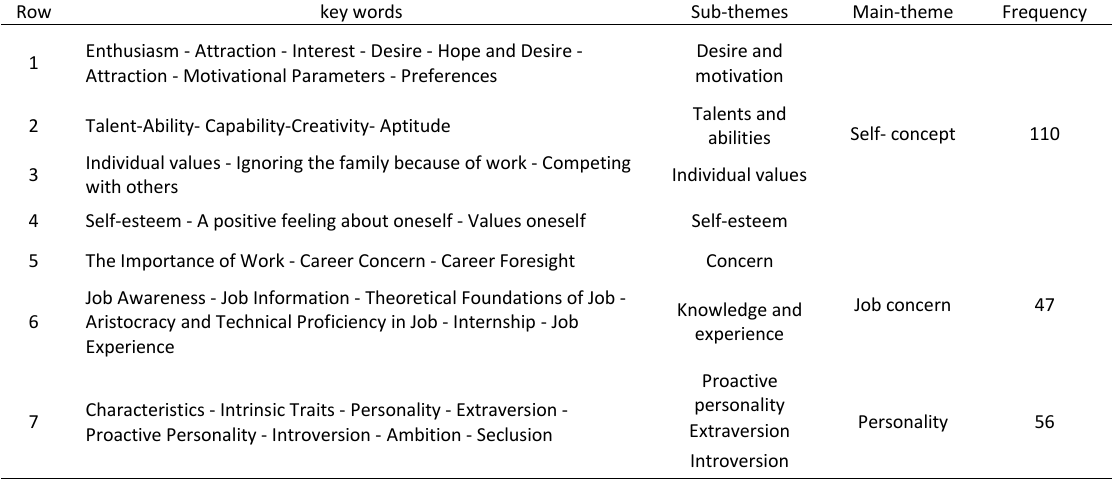
Table 2: Descriptive keywords, Sub-themes and Main-themes at the individual level